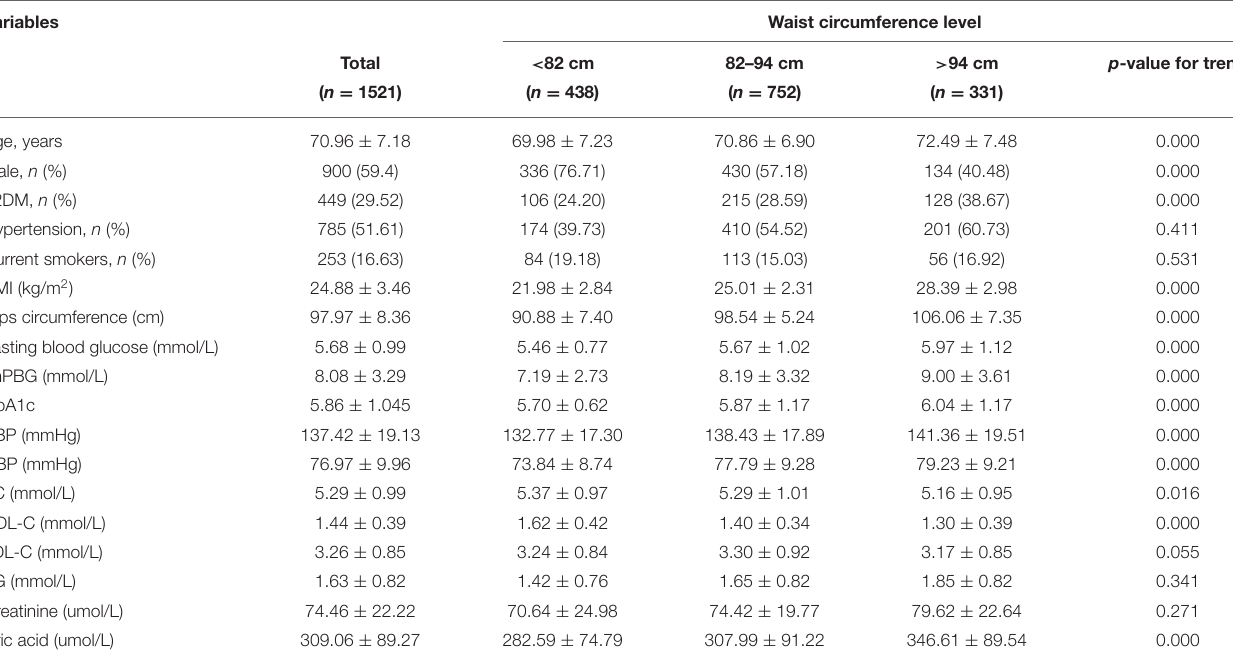
TABLE 1 | Baseline characteristics of the subjects by the waist circumference level.